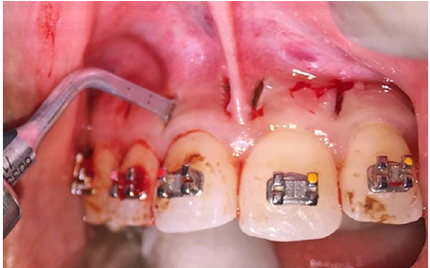
Figure 1. Piezocision flapless corticotomy procedure performed on maxillary anterior teeth. The surgical blade no 1 with millimeter marker showed 3 mm depth of